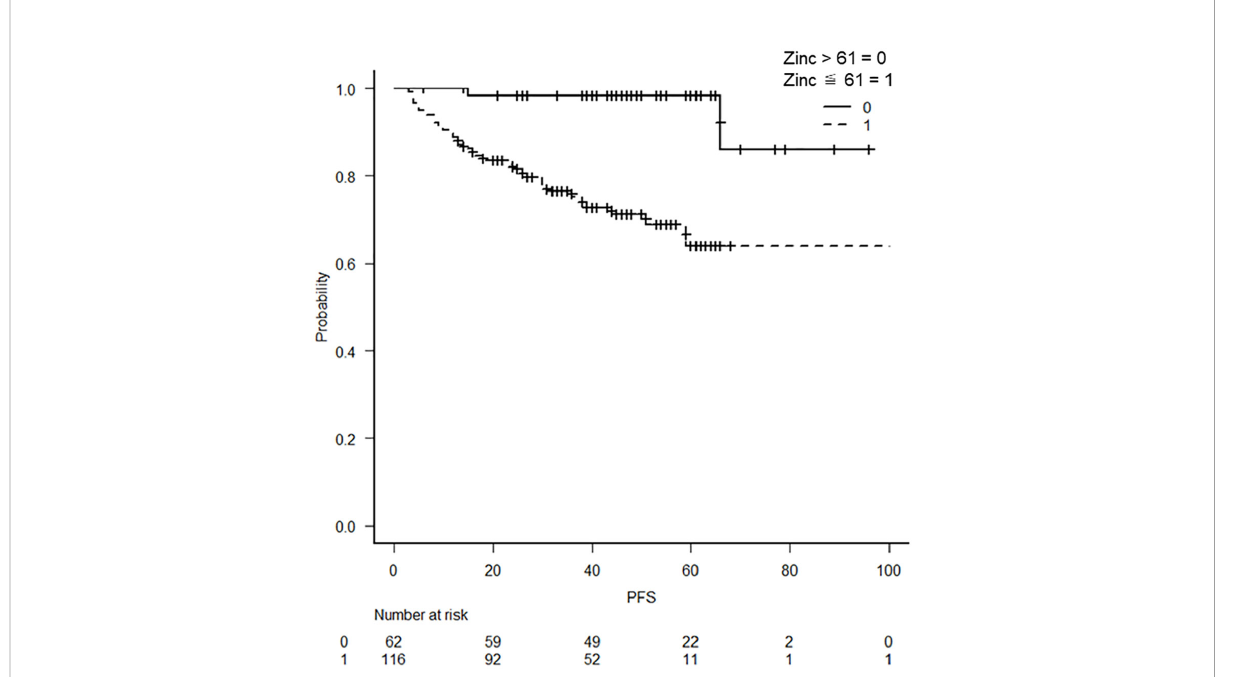
FIGURE 3 Kaplan – Meier curves with a cutoff at the lowest blood zinc concentration of 61 m g/dL Kaplan – Meier curves show a worse prognosis for serum zinc concentrations of ≤ 61 m g/dL (p = 0.0000244).